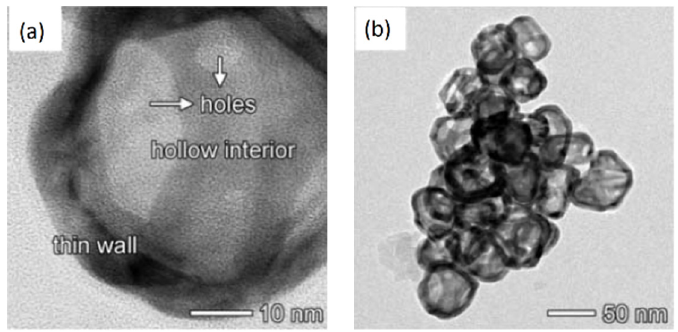
Figure 6. ( a ) and ( b) TEM images of gold nanocages; reproduced and adapted from [166]. Figure 6. ( a , b ) TEM images of gold nanocages; reproduced and adapted from